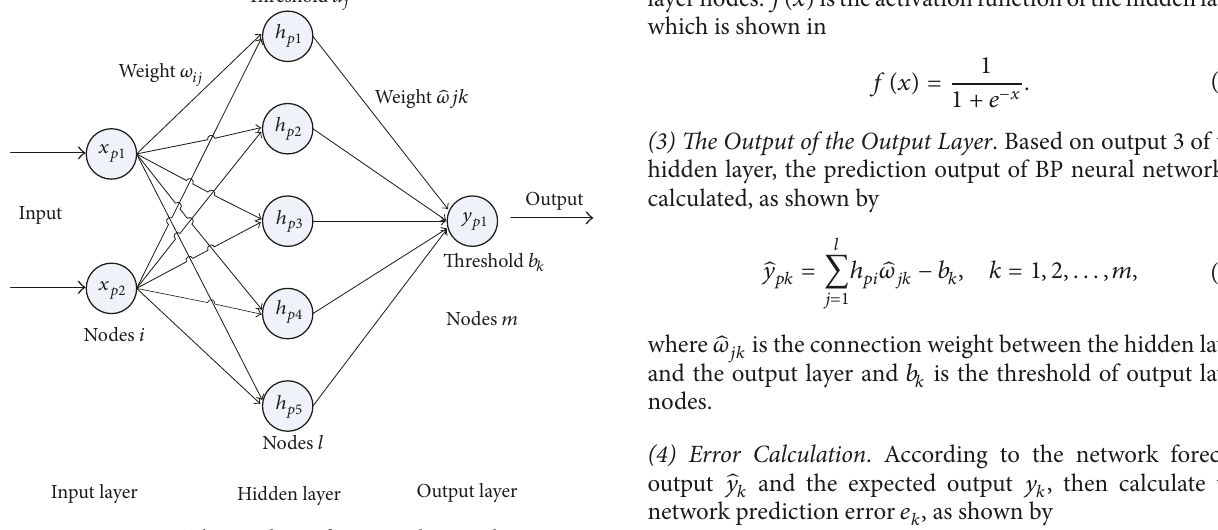
Figure 8: The topology of BP neural